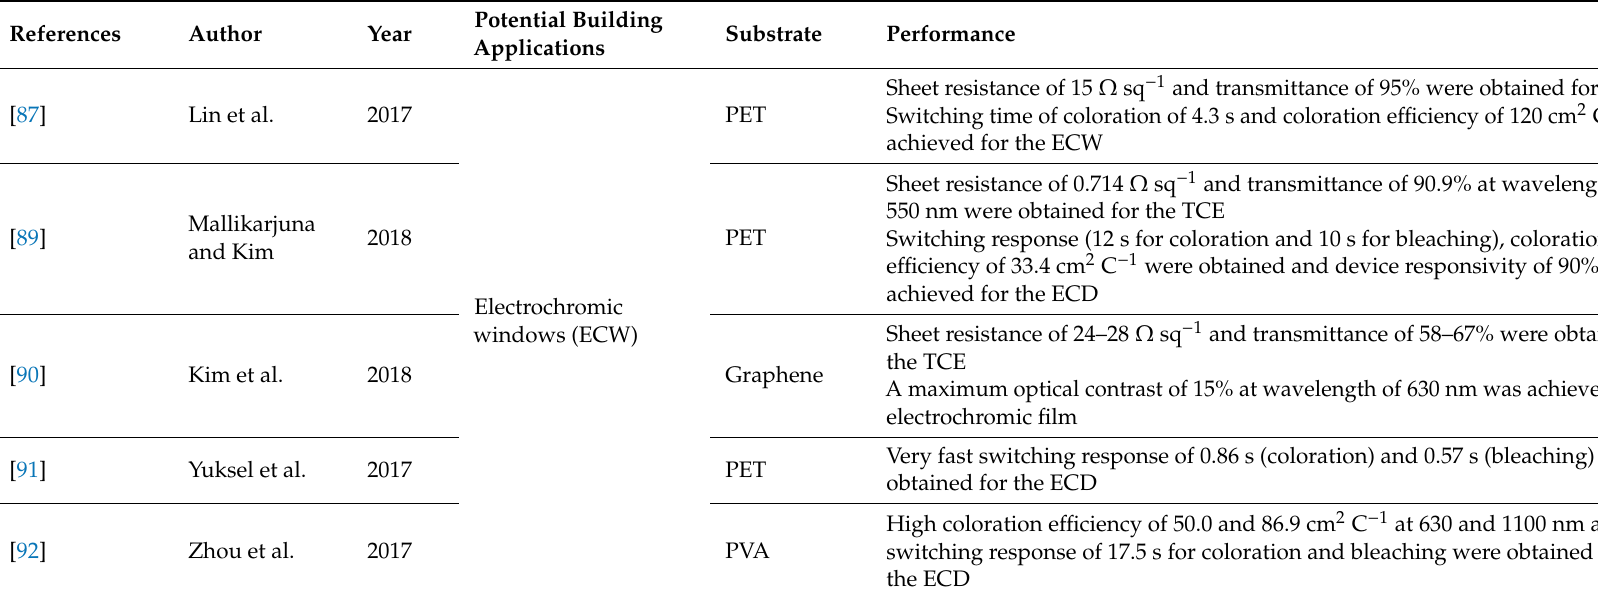
Table 4. Summary of AgNWs for fabricating TCE used in